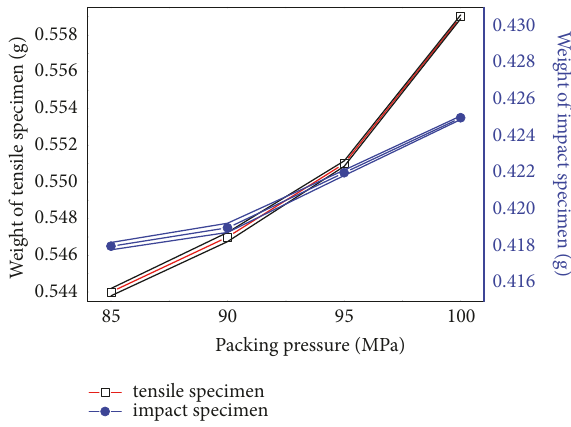
Figure 6: Influence of packing pressure on product weight.